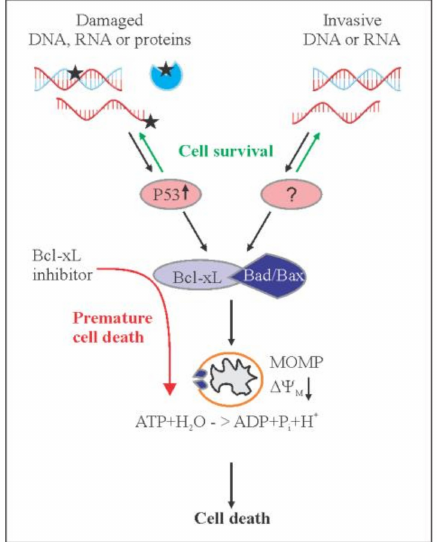
Figure 9. Schematic diagram showing how apoptosis could be initiated in response to chemical and physical stimuli or viruses, and how Bcl-xL-specific inhibitors could facilitate this process. Damage response (DR) factors and pattern recognition receptors (PRRs) recognize damaged molecules and invasive DNA or RNA, respectively. These proteins transduce signals to Bcl-xL via p53 or other protein(s). Pro-apoptotic Bax and Bad are released from anti-apoptotic Bcl-xL. When concentration of damaged or invasive molecules reach critical level, released Bax and Bad trigger mitochondrial outer membrane permeabilization (MoMP), which lead to inhibition of ATP synthesis, irreversible release of intermembrane space proteins, and subsequent caspase activation. This results in cell death. Alternatively, DR proteins and PRRs could mediate repair or degradation of damaged or invasive molecules, respectively, which would leave cells alive. Bcl-xL-specific inhibitors facilitate death of cells and, thus, impair repair or degradation of damaged or invasive